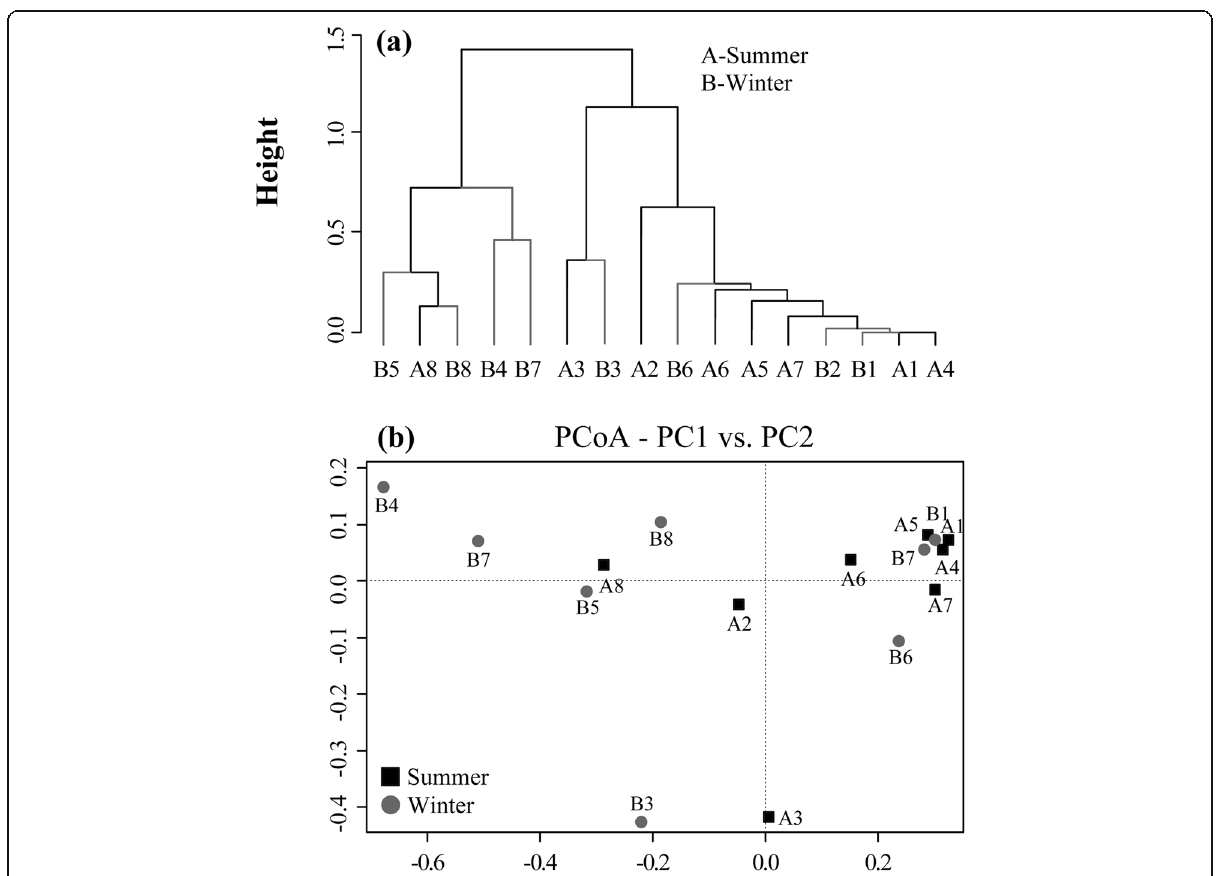
Fig. 3 a Complete cluster analysis showing the differences in the pmoA genes between summer and winter based on Bray Curtis distance. b Principal coordinate analysis (PCoA) for pmoA genes using Bray Curtis distance. Bray Curtis distances were calculated using the relative abundance of the genes. The letter A represents pmoA genes in summer, and the letter B represents the genes